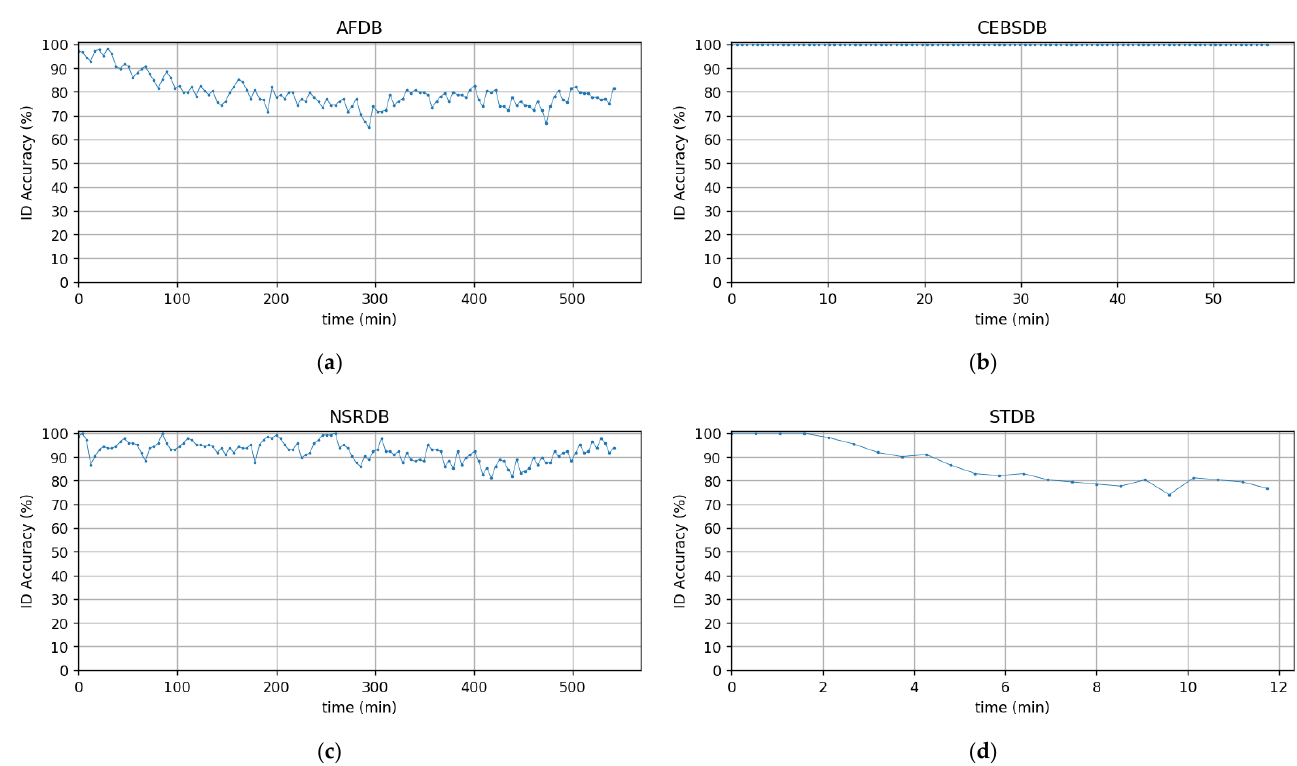
Figure A10. Area under ROC curve of scope verification is plotted against time separation for: ( a ) AFDB, ( b ) CEBSDB, ( c ) NSRDB, ( d ) STDB.